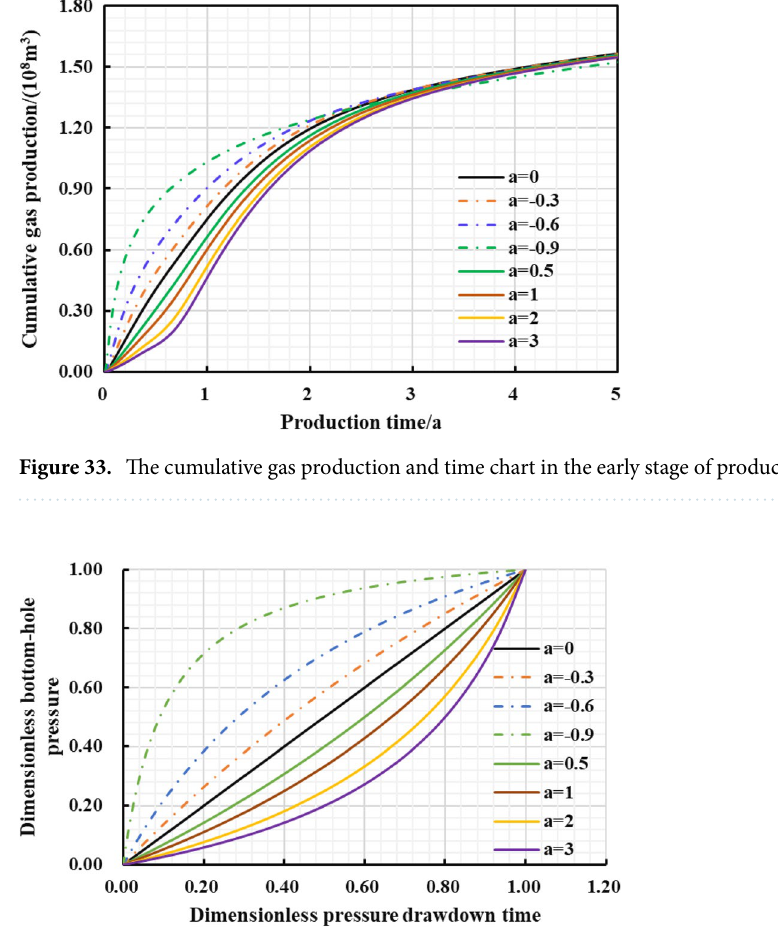
Figure 34. Dimensionless bottom hole pressure and pressure drop time chart under different pressure drop paths.